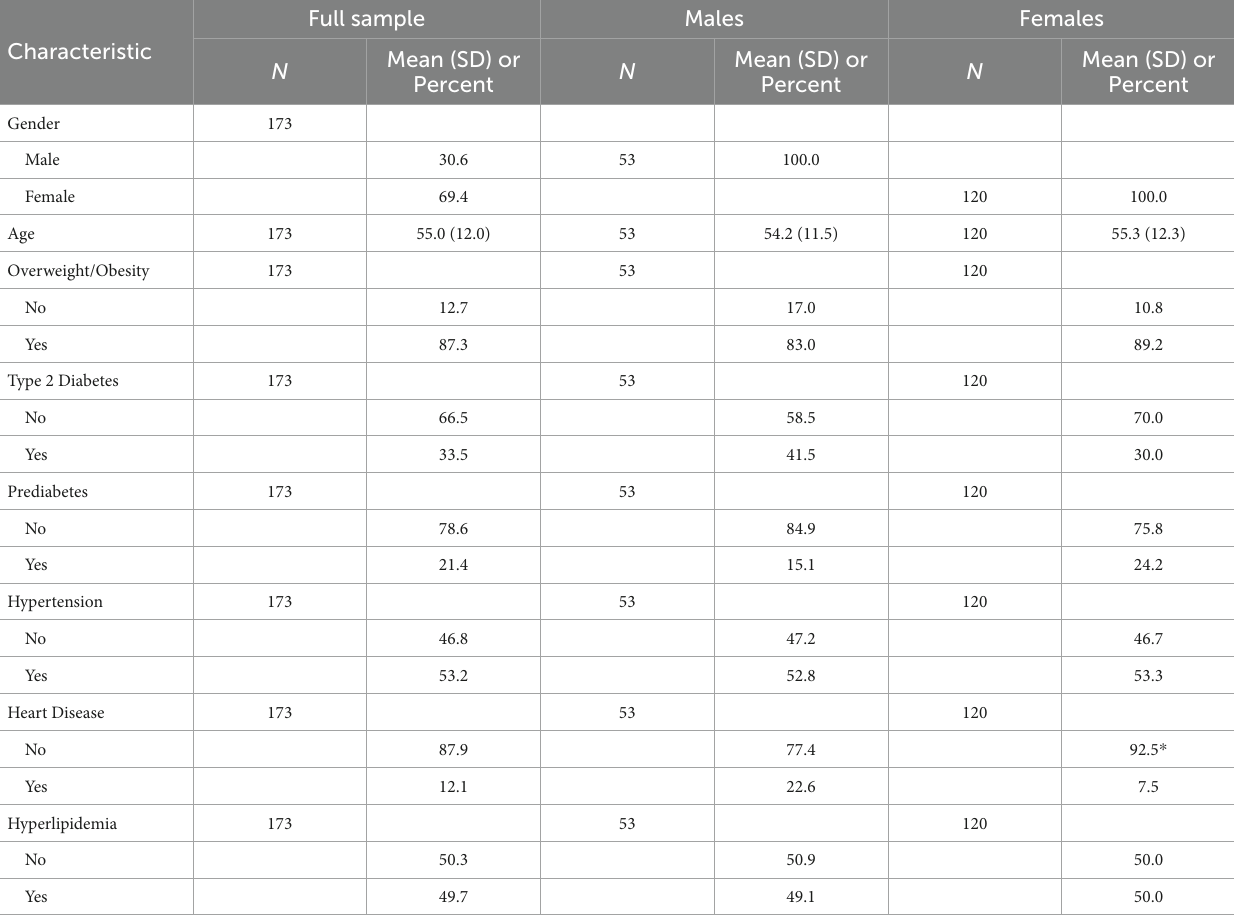
TABLE 1 Sample characteristics and baseline diagnoses by gender ( n = 173).